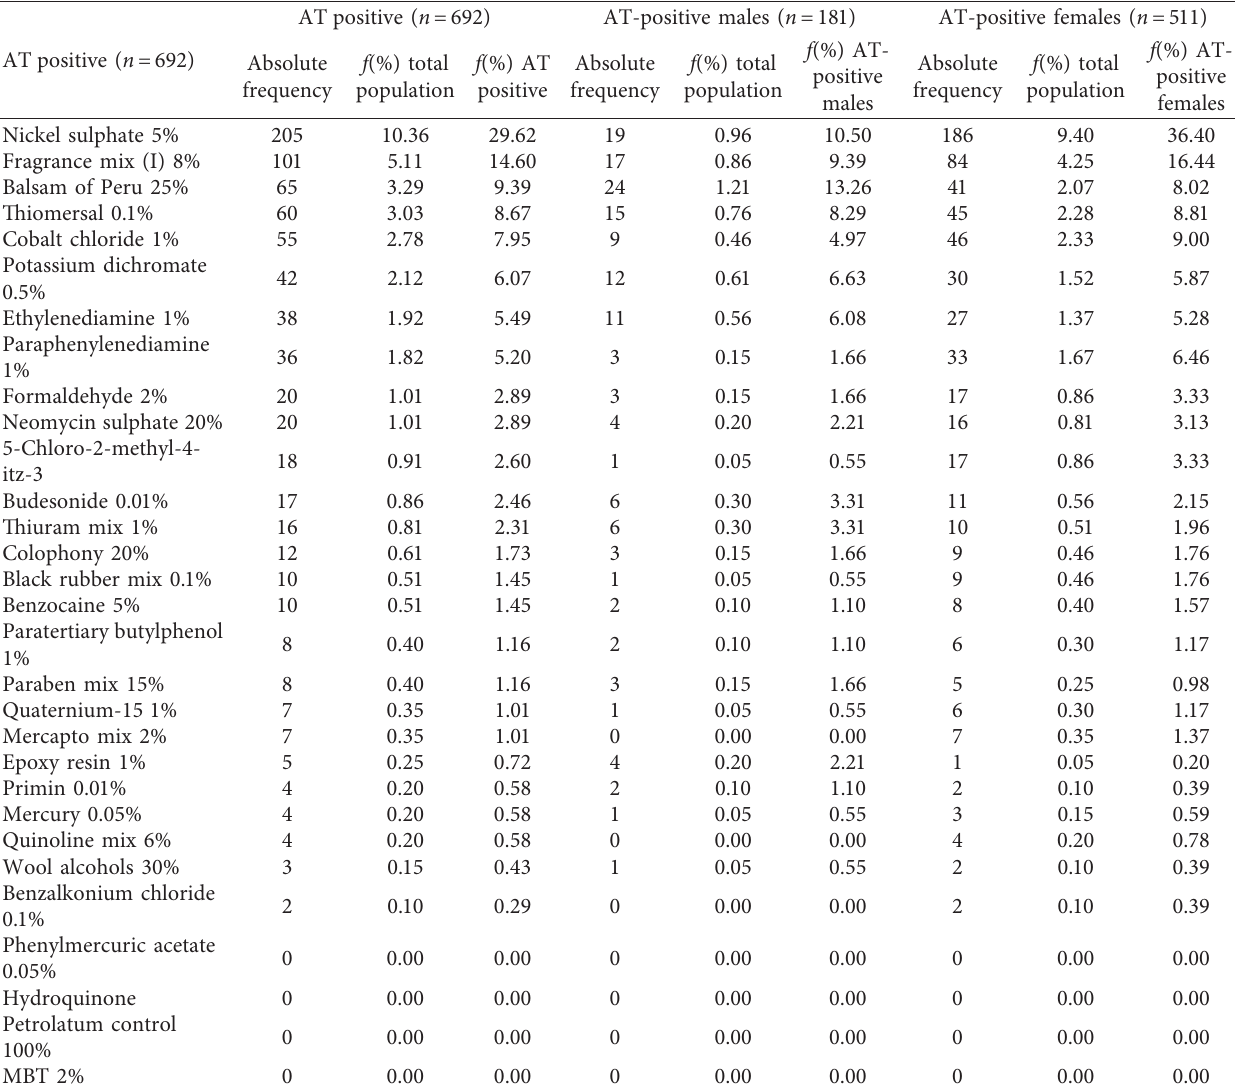
Table 3: Frequencies of the most prevalent allergens in the population with atopic dermatitis (AT), with respect to the total population, as well as the male and female